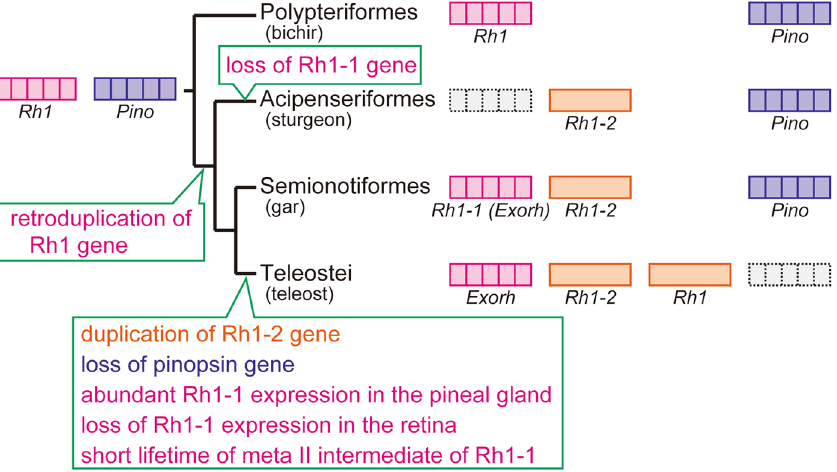
Figure 7. Stepwise evolutionary model of rhodopsin genes in the Actinopterygii. Fishes in the Polypteriformes maintain a single intron-containing rhodopsin gene ( Rh1 ) and pinopsin gene like tetrapods. After branching of the Polypteriformes, retroduplication resulted in the formation of intron-less rhodopsin gene ( Rh1-2 ). In the lineage of the Acipenseriformes, we speculate that intron-containing Rh1-1 ( Exorh ) might have been lost probably because of the functional redundancy of rhodopsin and pinopsin in the pineal gland. Fishes in the Semionotiformes maintain two rhodopsin genes ( Rh1-1 ( Exorh ) and Rh1-2 ) and pinopsin gene. By